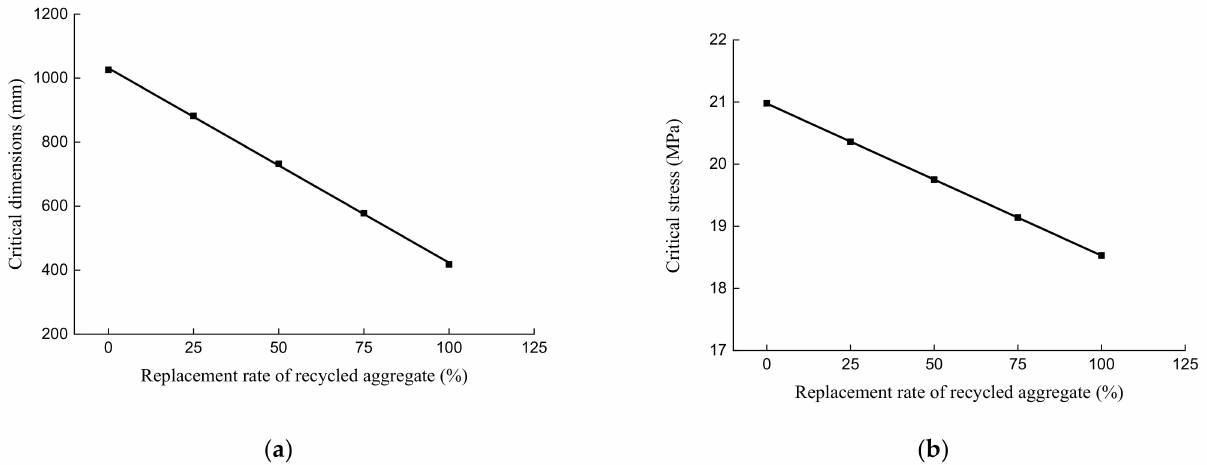
Figure 12. Correlation between the critical dimension and critical stress of recycled aggregate concrete: ( a ) critical dimension; and ( b ) critical